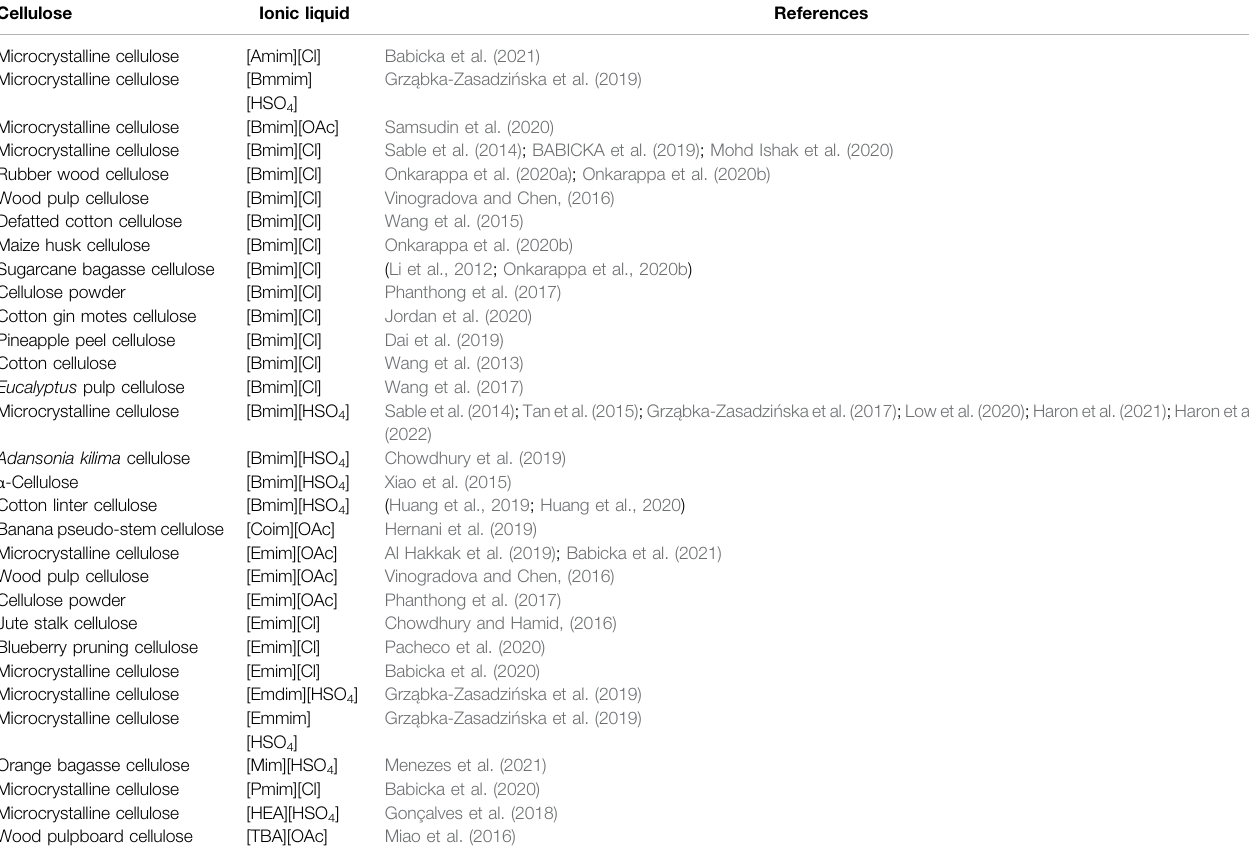
TABLE 2 | Examples of celluloses and ionic liquids used for the extraction of nanocellulose. Cellulose Ionic liquid